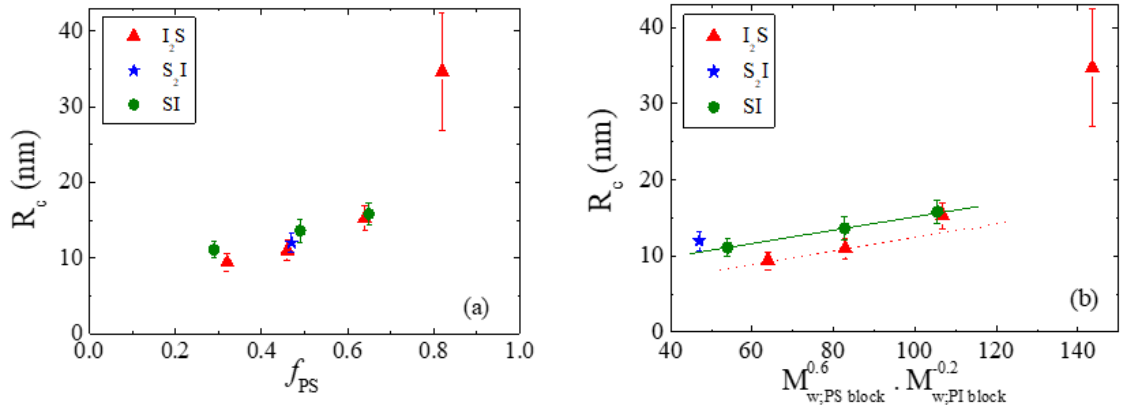
Figure 2. ( a ) The composition dependence of the radius R c of the micellar core formed in the 2 wt% blends of the I 2 S graft (solid triangles), the S 2 I graft (star), and the linear copolymers (solid circles), within the polyisoprene matrix at room temperature, as derived from the form factor analysis. The error bars correspond to the fitted polydispersity. ( b ) Core radius of the micelles formed in the 2 wt% blends of the I 2 S (solid triangles) and S 2 I (star) grafts, and the SI diblock copolymers (solid circles) in the polyisoprene matrix at room temperature, as a function of the particular relations to the molecular weights of the core-forming (PS) and corona-forming (PI) blocks (see text). The solid line corresponds to the data for the SI diblocks, whereas the dotted line has the same slope with the solid one and is followed by the I 2 S data only at low values of f PS .